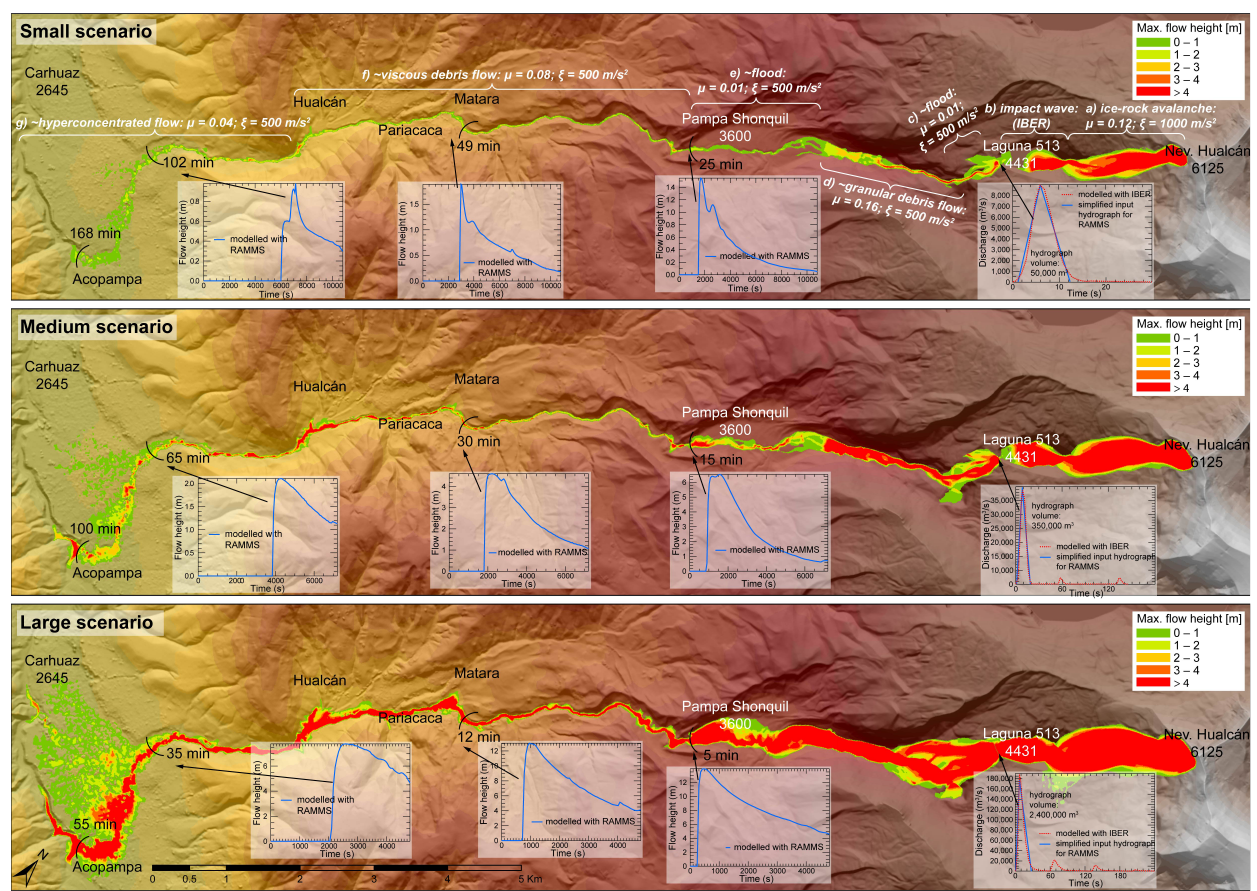
Fig. 5. Numerical modeling results (RAMMS) of three scenarios (small, medium, large) of potential mass movement process chains. The graph showing the small scenario includes indications of frictional parameters used in the RAMMS model which is valid for all three scenarios (white font). The dimensions of the ice-rock avalanche, dam overtopping flood wave, and flood, hyperconcentrated flow and debris flow for each scenario are given in Table 1. The three discharge hydrographs near the initiation area correspond to the output hydrograph calculated by the IBER model (red dotted line) and the simplified (blue) hydrograph has been used as input hydrograph for RAMMS. The three flow height hydrographs downstream have been calculated with RAMMS for a pixel at the center of the river. Note also the flow durations which are indicated in minutes along the flow path. Background: color-shaded relief of WorldView